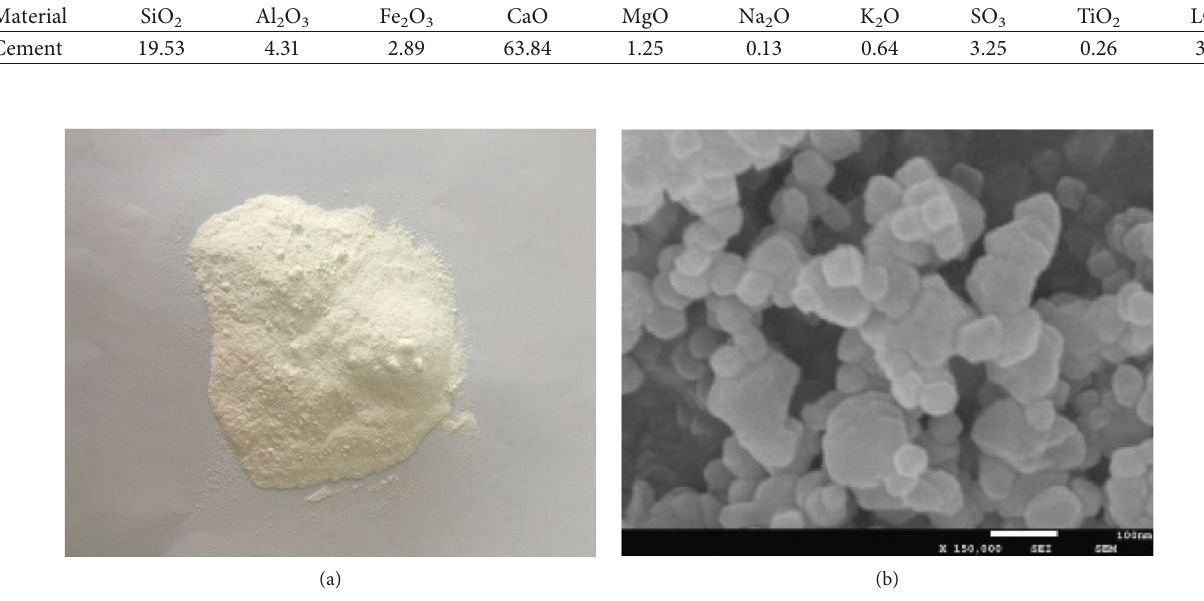
Figure 1: NC diagram. (a) NC powder. (b) SEM image of NC.